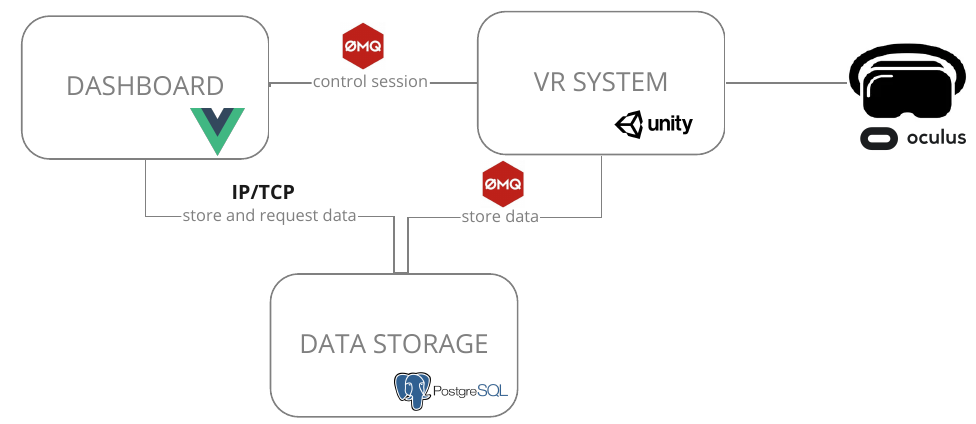
Figure 10. The architecture of the designed VR platform.